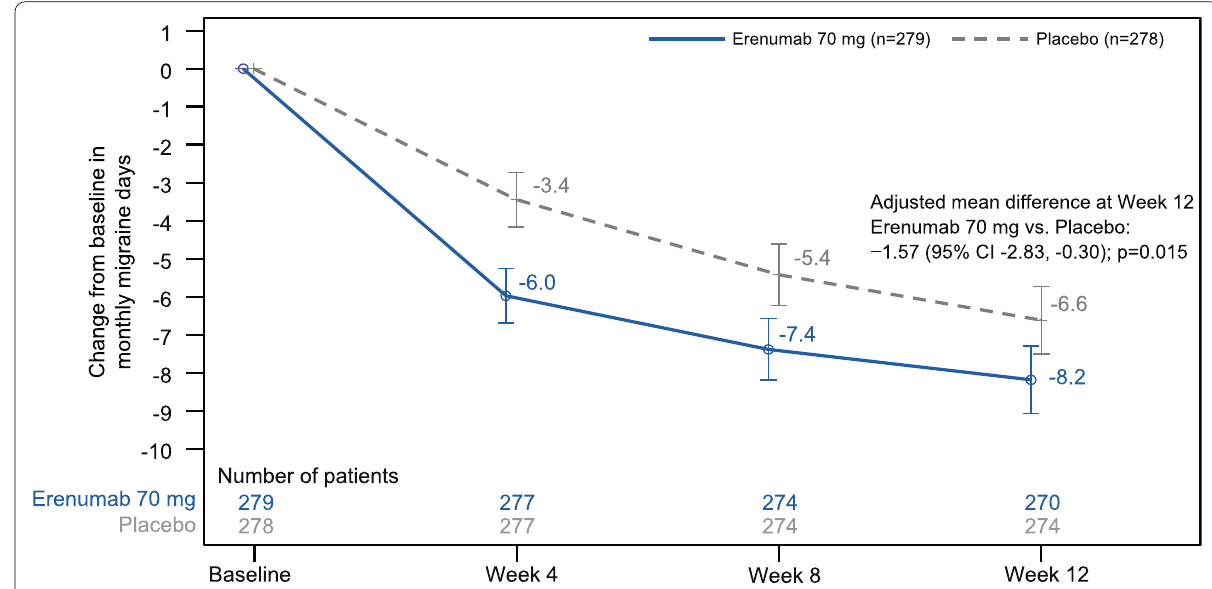
Fig. 2 Change from baseline in MMD by treatment and visit (Full analysis set). Adjusted LSM and 95% CIs from the primary analysis model are presented. Note: The primary efficacy endpoint (change from baseline in MMD) was analysed using a generalised linear mixed effects repeated measures model based on observed monthly data during the treatment period. CI, confidence interval; LSM, least‑squares means; MMD, monthly